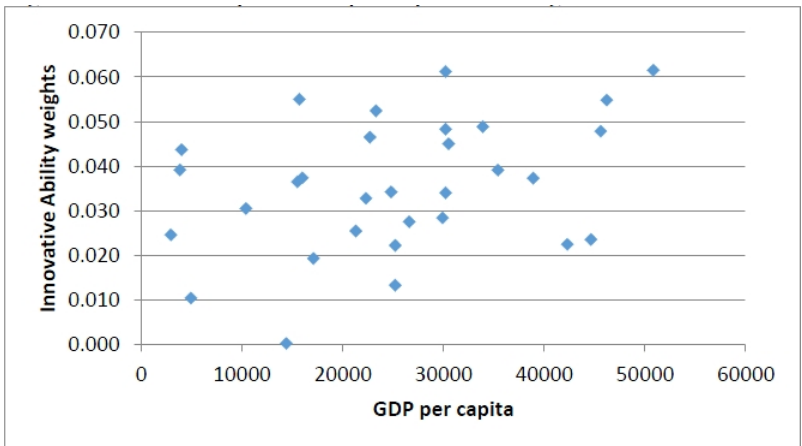
Figure 8. Relationship of GDP per capita and weights of “Stability of energy generation”.